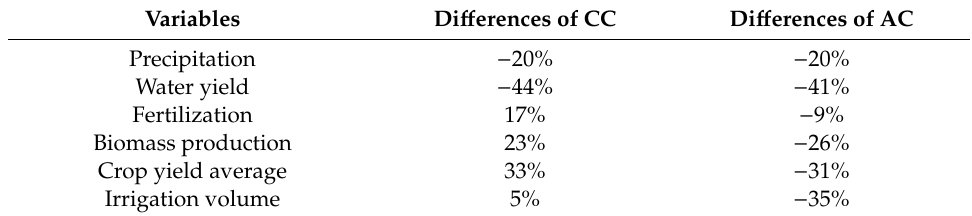
Table 4. Percentage of variable di ff erences for conventional calibration (CC) and additional calibration (AC) between the regular precipitation and a decrease of 20% of rainfall from 2000 to 2010. A positive percentage represents an increase of the variable whereas a negative value means a decrease. Variables Di ff erences of CC Di ff erences of AC Precipitation − 20% − 20% Water yield − 44% − 41% Fertilization 17% − 9% Biomass production Crop yield